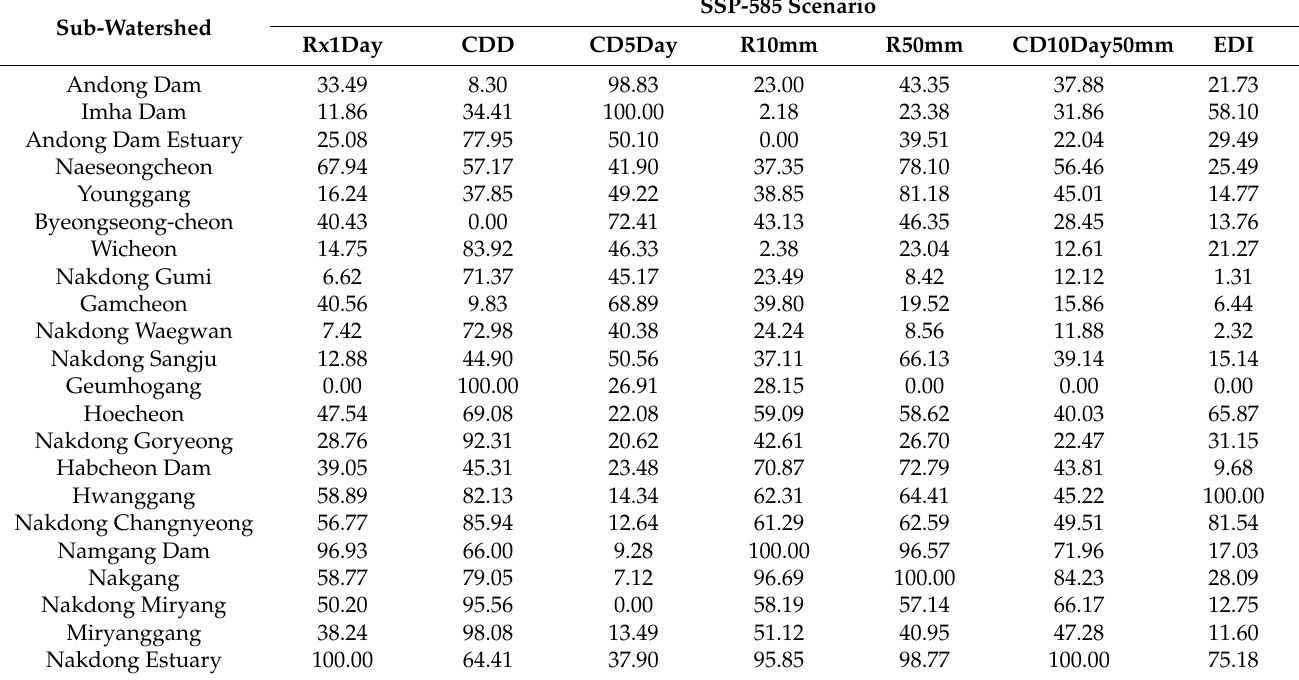
Table 8. Standardized indices of climate change exposure in scenario